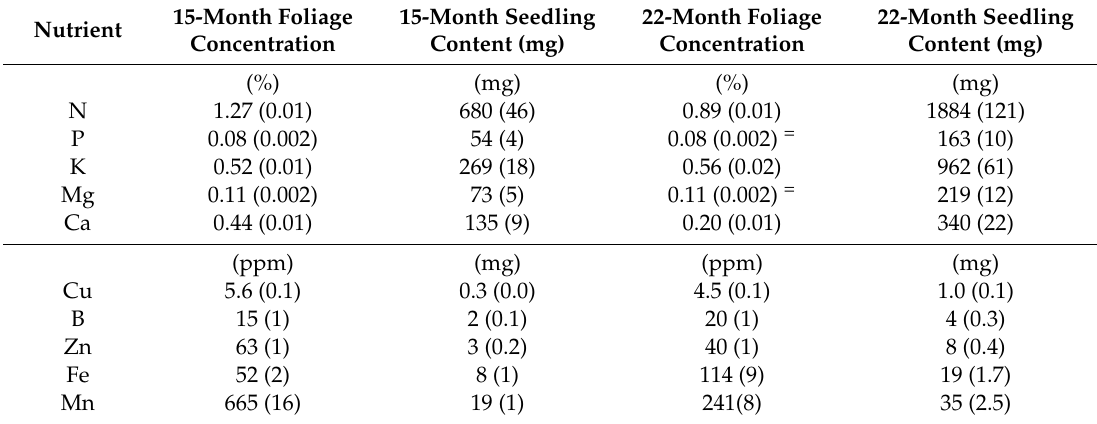
Table 4. Across nursery treatments means (1 SE) of foliar nutrient concentrations and total seedling nutrient contents among individuals excavated 15 and 22 months after outplanting. For the 22-month seedlings, means followed by = are not significantly di ff erent at α = 0.05 from the means of the 15-month